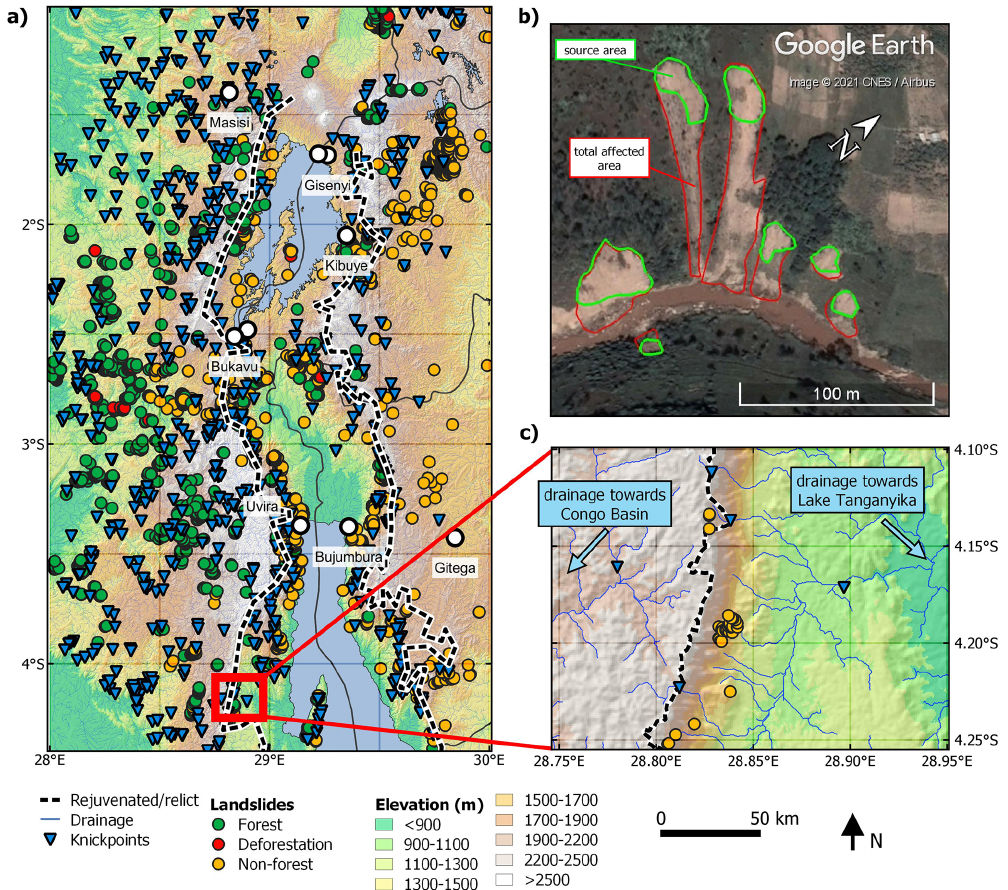
Figure 7. Landslide and knickpoint inventory for the NTK rift. (a) We identified 7994 shallow recent landslides that occurred either in forest, non-forest, or after deforestation and 673 non-stationary knickpoints. These knickpoints were used to separate the rejuvenated landscapes between the rift shoulders from the surrounding relict landscapes (black and white line). (b) Example of shallow landslides in Rwanda ( − 1.7151 ◦ S, 29.7909 ◦ E) and the delineation of their total area (red) and source area (green). (c) Example of the rift shoulder west of Lake Tanganyika. The method for delineating the rejuvenated landscapes is specified in Sect.